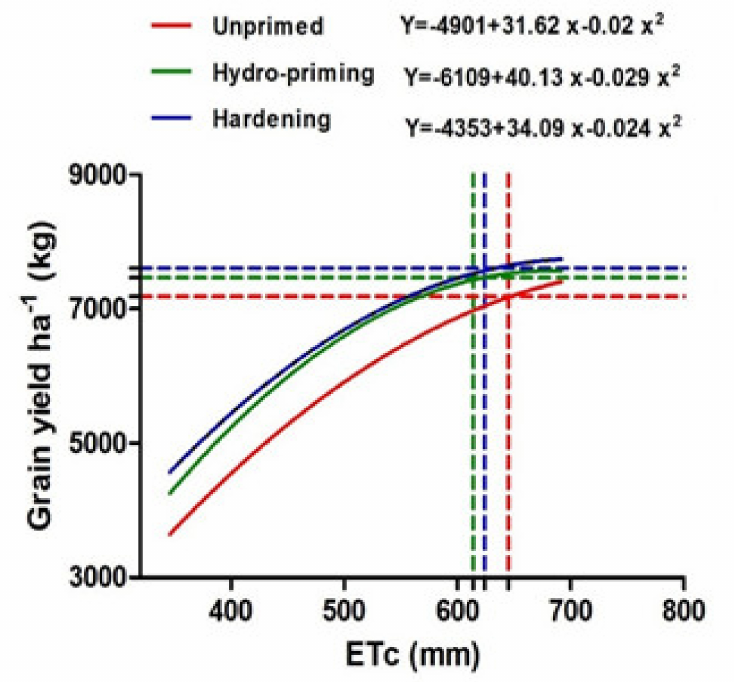
Figure 4. Grain yield response to irrigation water amount and identifying optimum irrigation amount for the three priming treatments. The dotted vertical lines indicate the optimum irrigation amount, and horizontal lines indicate the expected grain yield for each priming